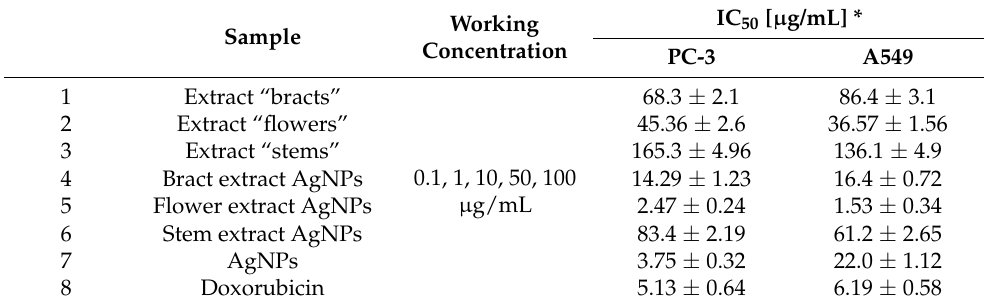
Table 3. Summarized IC 50 values for different extracts with AgNPs of Cynara scolymus